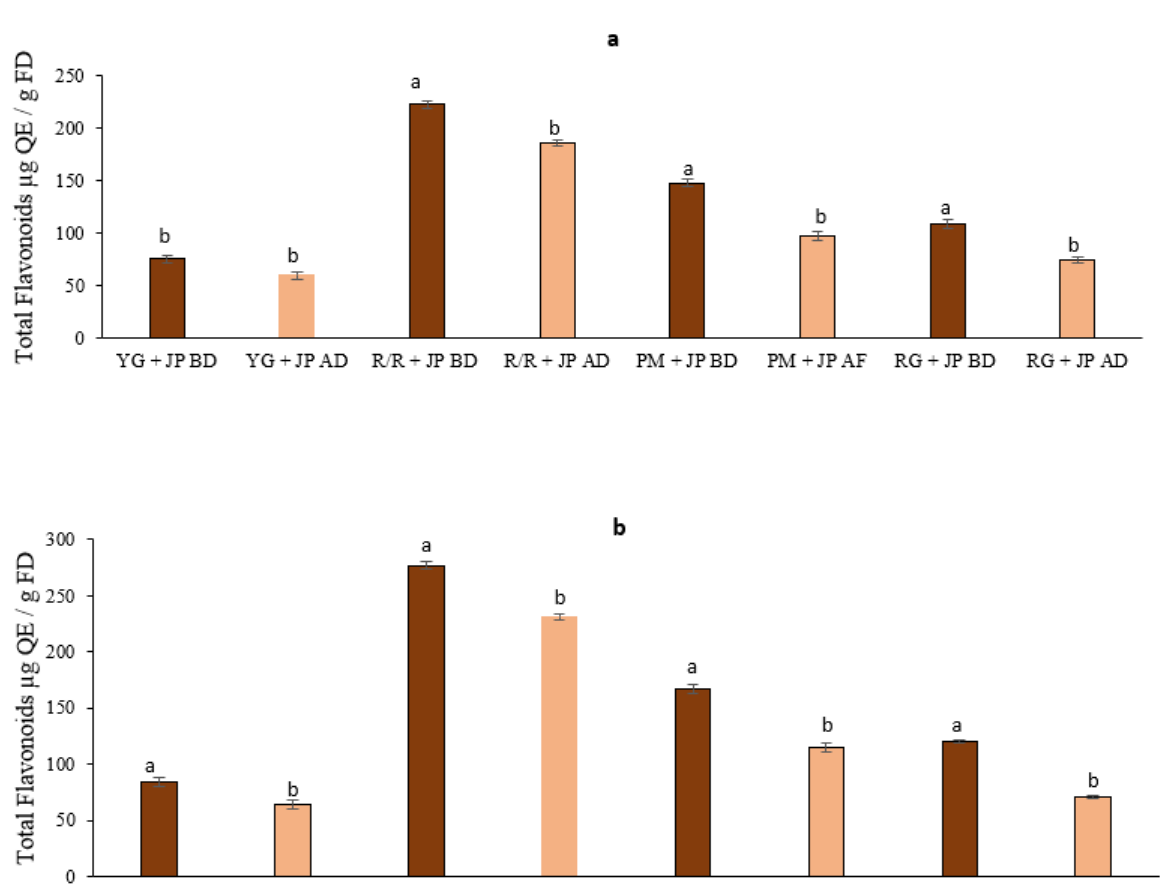
Figure 2. The levels of total flavonoids and bioaccessibility of cooked potato cultivars mixed with roasted JP ( a ) and roasted SD ( b ). Data are the mean of three replicates with standard deviation and expressed as per gram of freeze-dried weight. Significant differences are denoted by different letters, while the same or shared letters indicate that they are not significant to each other. AD and BD: before and after digestion.